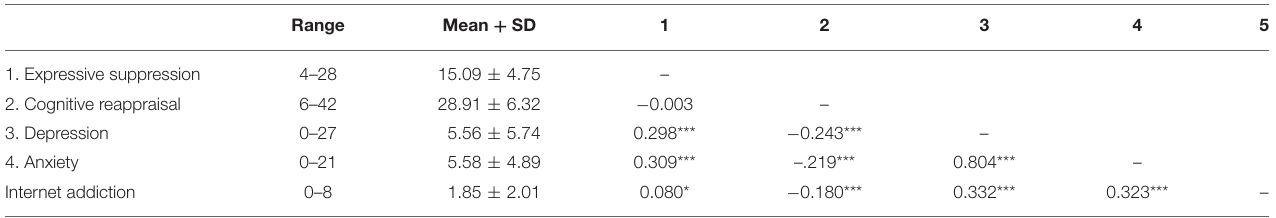
TABLE 2 | Correlation among the main variables for all sample.